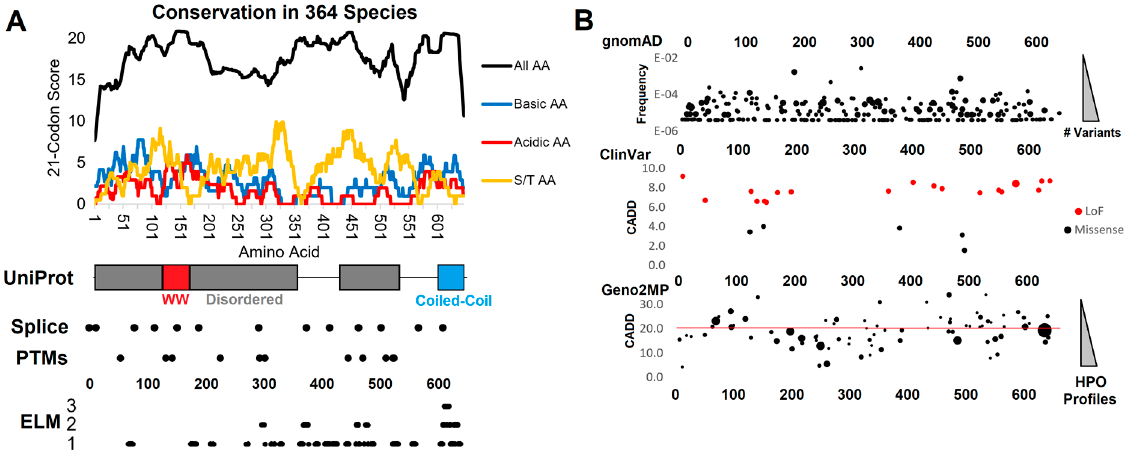
Figure 1. Genomic analysis of WAC . ( A ) Compiled genomics insights for WAC. On top is the conservation of 364 species of WAC protein. The conservation score of all amino acids (black) is based on the amino acid % of species conserved at each amino acid (0—no conservation, 1–100% conserved), placed on a 21 codon sliding window such that each site is added to 10 upstream and 10 downstream. The basic (blue, R/K/H), acidic (red, D/E), or S/T (orange) amino acid scores are calculated using only these amino acids for the same 21 codon window. Below is conservation of the amino acid locations (x-axis) for UniProt annotated domains/motifs, splice sites, posttranslational modifications (PTMs), and ELM annotated motifs (y-axis lists the number of annotations at each amino acid). ( B ) Extracted genomic variants from gnomAD (y-axis list allele frequency, bubble size is the number of unique variants), ClinVar (y-axis is the CADD functional score, color represents the type of variant), and Geno2MP variants (y-axis is the CADD score, bubble size the number of human phenotype profiles). Abbreviations—AA, amino acid; R, arginine; S, serine; T, threonine; LoF, loss-of-function; ELM, eukaryotic linear motif; HPO, human phenotype ontology.